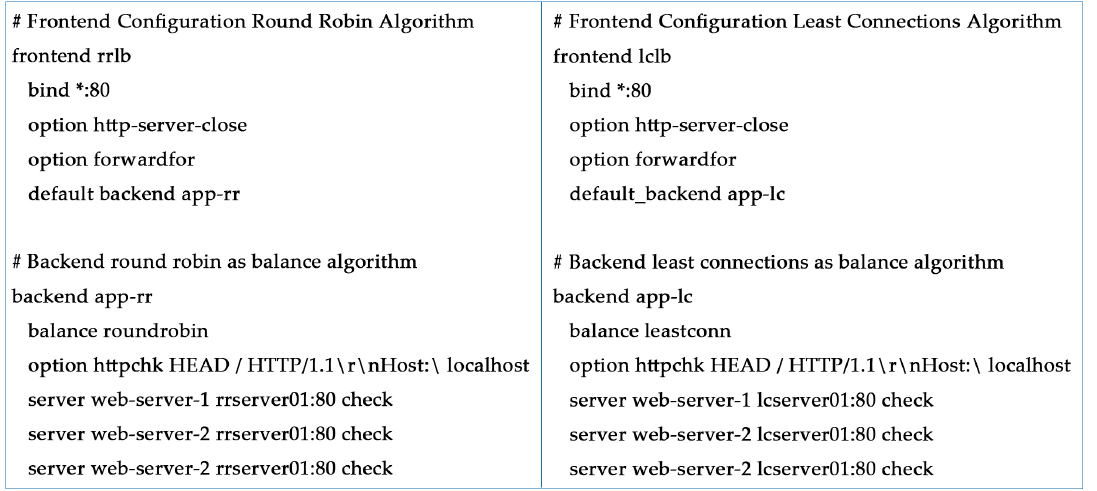
Figure 9. Model of the least connections algorithm.